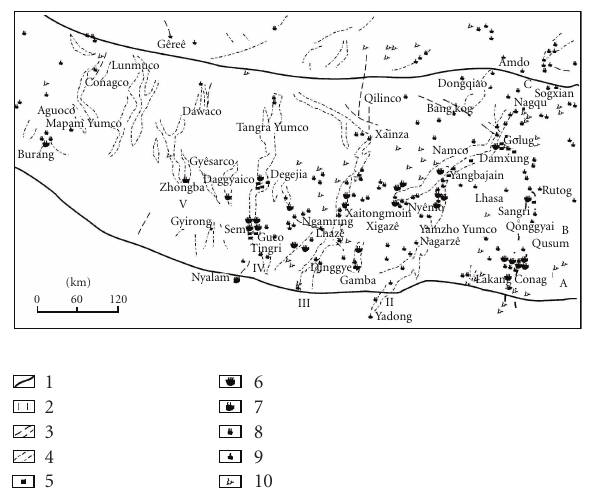
Figure 10: Distribution of hydrothermal manifestations in the Lhasa block of the Tibetan plateau (about 80–94 ◦ E, 27–33 ◦ N). 1: Early major compressive or compressive-shear fault: the upper one is the Bangong-Nujiang suture zone, and the lower one is the Yarlung Zangbo Jiang suture zone; 2: the number of active tectonic zone; 3: boundary fault in active tectonic zone; 4: faulted-depression zone in active tectonic zone; 5: site of sampling; 6: boiling spring; 7: hydrothermal explosion, geyser and boiling fountain; 8: thermal spring; 9: hot spring; 10: untested hydrothermal area (according to [21]).